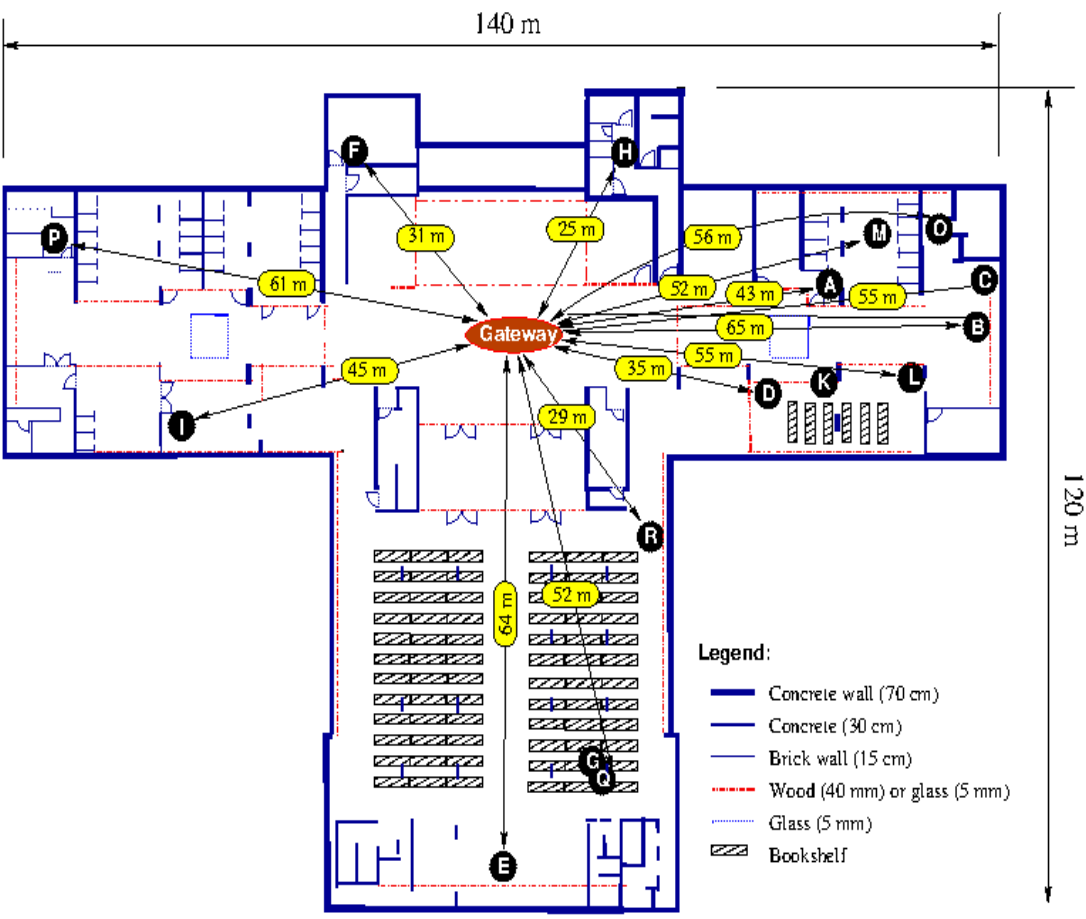
Figure 10. Floor plan of Qatar University library building used for evaluating packet loss of the radio transmission channel.